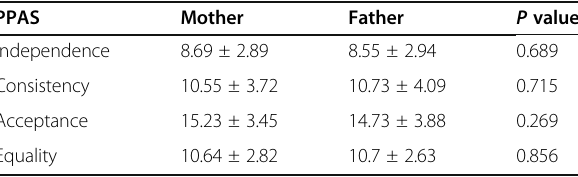
Table 1 ADHD children ’ s perceived parenting attitudes from both mothers and fathers